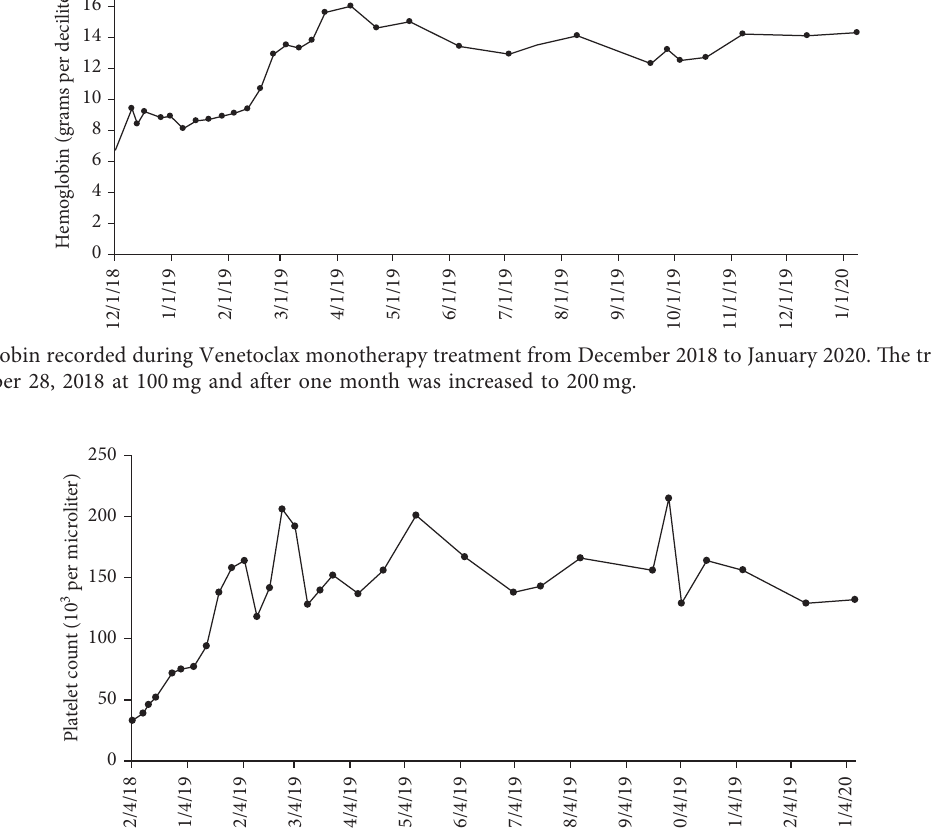
Figure 3: Platelet count recorded during Venetoclax monotherapy treatment from December 2018 to January 2020. The treatment initially began on November 28, 2018 at 100mg and after one month was increased to